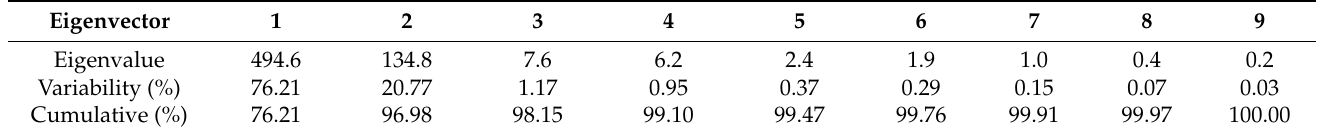
Figure 4. Fourier-transform infrared (FTIR) spectra of SASP, FA and their blends. The results of the PCA analysis showed that eigenvalues of the nine obtained eigen- vectors ranged from 494.6 to 0.2, whilst the data variability was in range from 76.21% to 0.03% (Table 2). Table 2. Eigenvalues and variances of the nine obtained principal